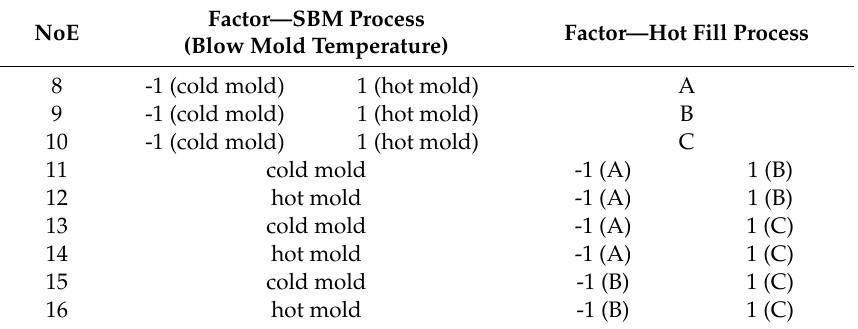
Table 7. Plans for nine one-factor, bivalent experiments for testing pressure resistance and thermal stability (NoE—Number of Experiment).